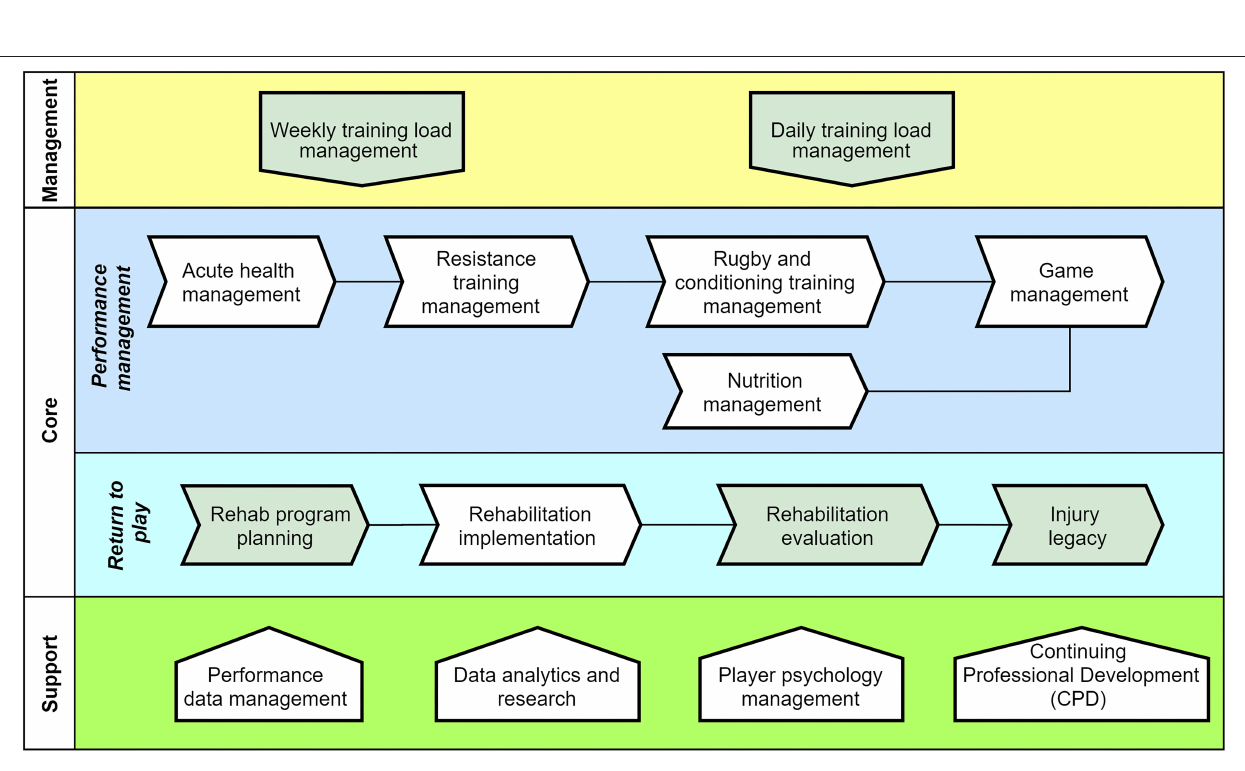
FIGURE 3 | High-Performance Unit process landscape model.